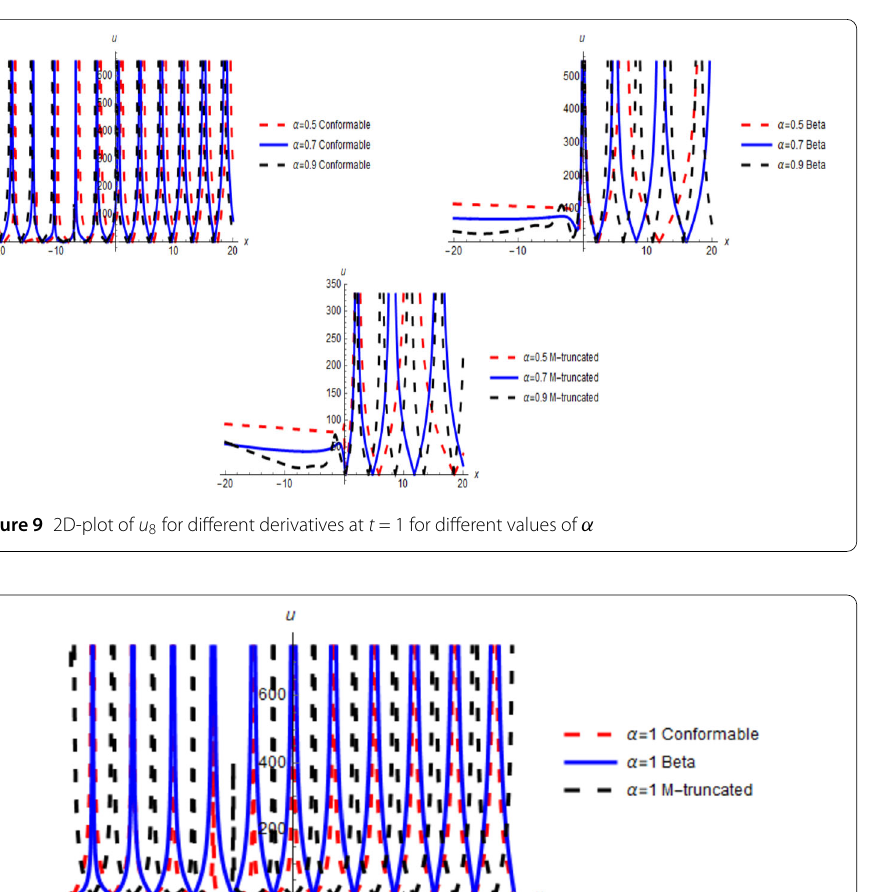
Here, it is important to mention that for u 1 ( x , t ) no overlapping is seen between the curves by testing different fractional values of α , but in Fig. 5 the same curves are obtained for conformable and M-truncated derivative with α = 1, while the same solution shows different behavior for the same values of physical parameters for beta